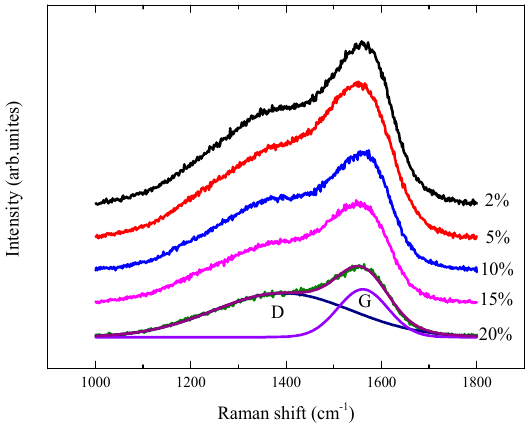
Figure 7. Raman spectra of the Cr-DLC films deposited at different set values.